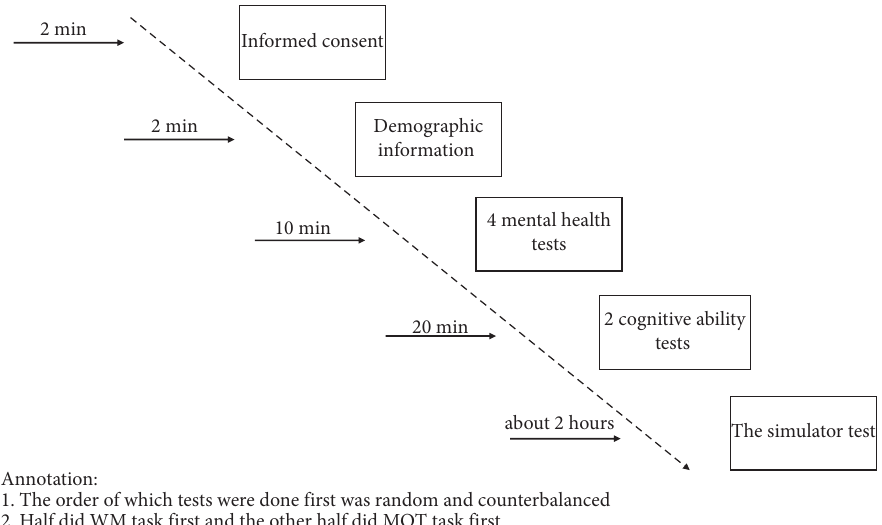
Figure 4: The experimental